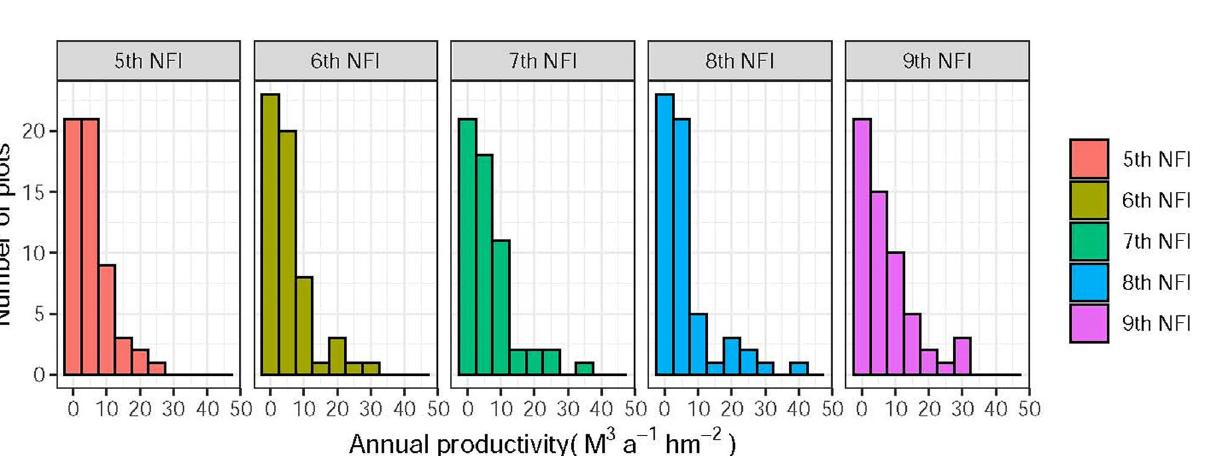
Table 4. Relationship between Continuous planting time and Mean productivity of reserved and newly- cultivated eucalyptus sample plots during different NFIs (unit: m 3 hm −2 a −1 ).